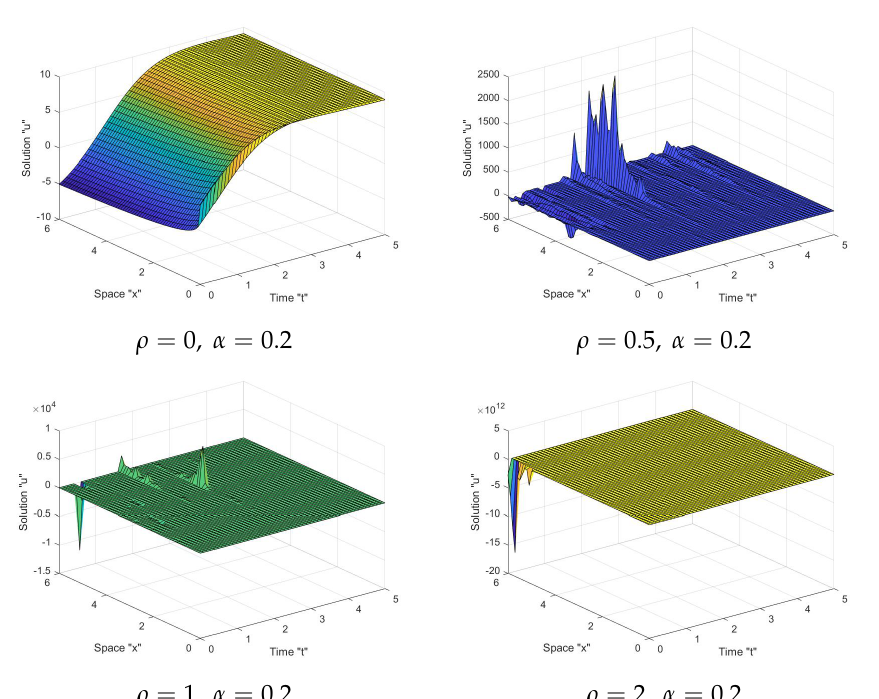
Figure 3. Graph of solution u 2 in Equation (21) with α =